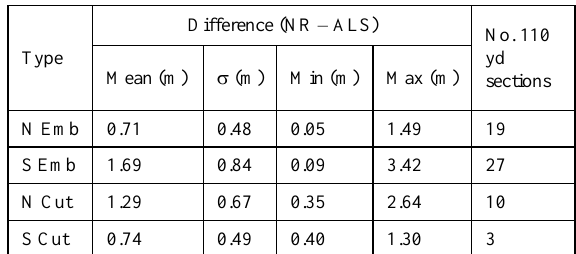
Table 4. Difference statistics for ALS-derived slope heights compared to those evaluated by